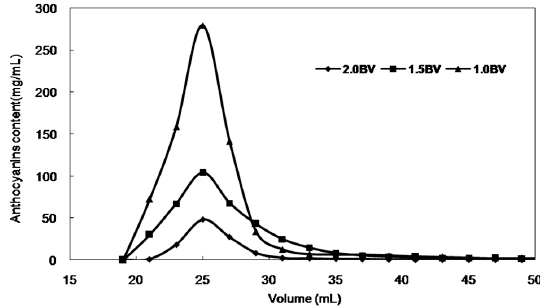
Figure 6. Dynamic desorption curves with different current velocities (the ordinate is the desorption content of anthocyanins).